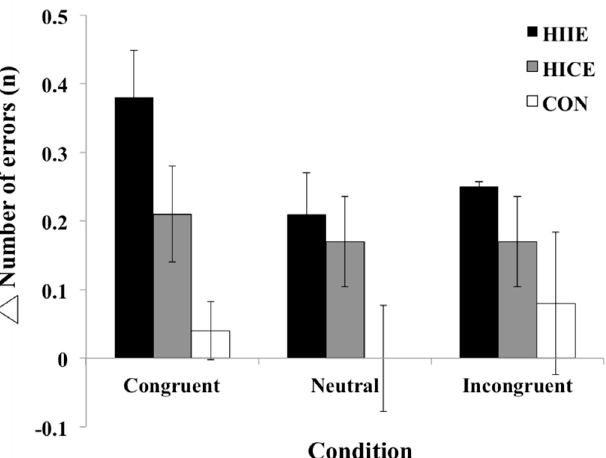
Figure 2. Mean and SE of the Δ (difference between pre-test and post-test) number of errors in the Stroop task among the three groups (The High-intensity interval exercise (HIIE) group, the High- intensity continuous exercise (HICE) group and the Control (CON) group). No significant difference and interactions among these three groups and three stimulus conditions (Congruent, Neutral and Incongruent condition) ( p > 0.05).